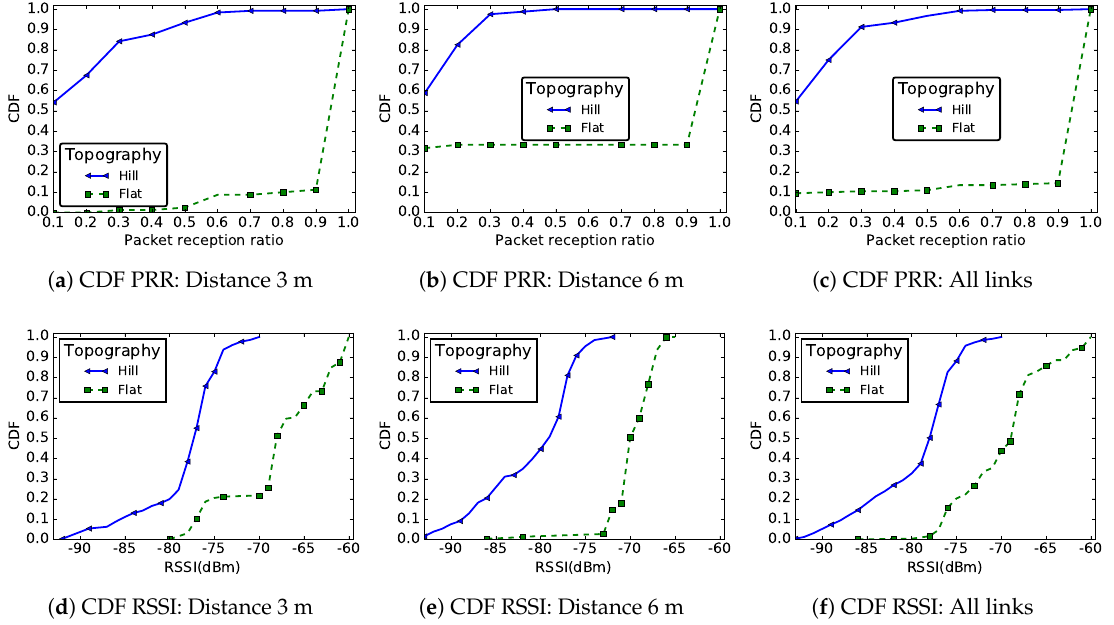
Figure 13. CDF of PRR and RSSI for links with distances 3 m and 6 m, as well as for all the links in the network in the case of a hill and a flat area